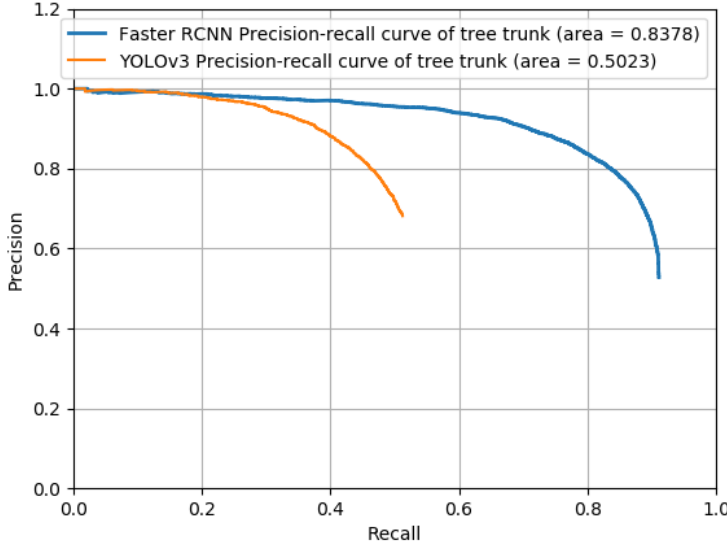
Figure 12. Precision-recall curve of Faster R-CNN and YOLOv3 testing.